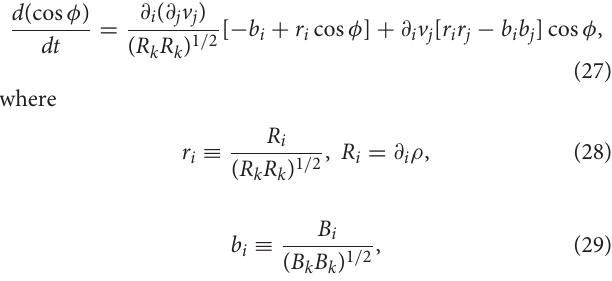
Frontiers in Astronomy and Space Sciences |